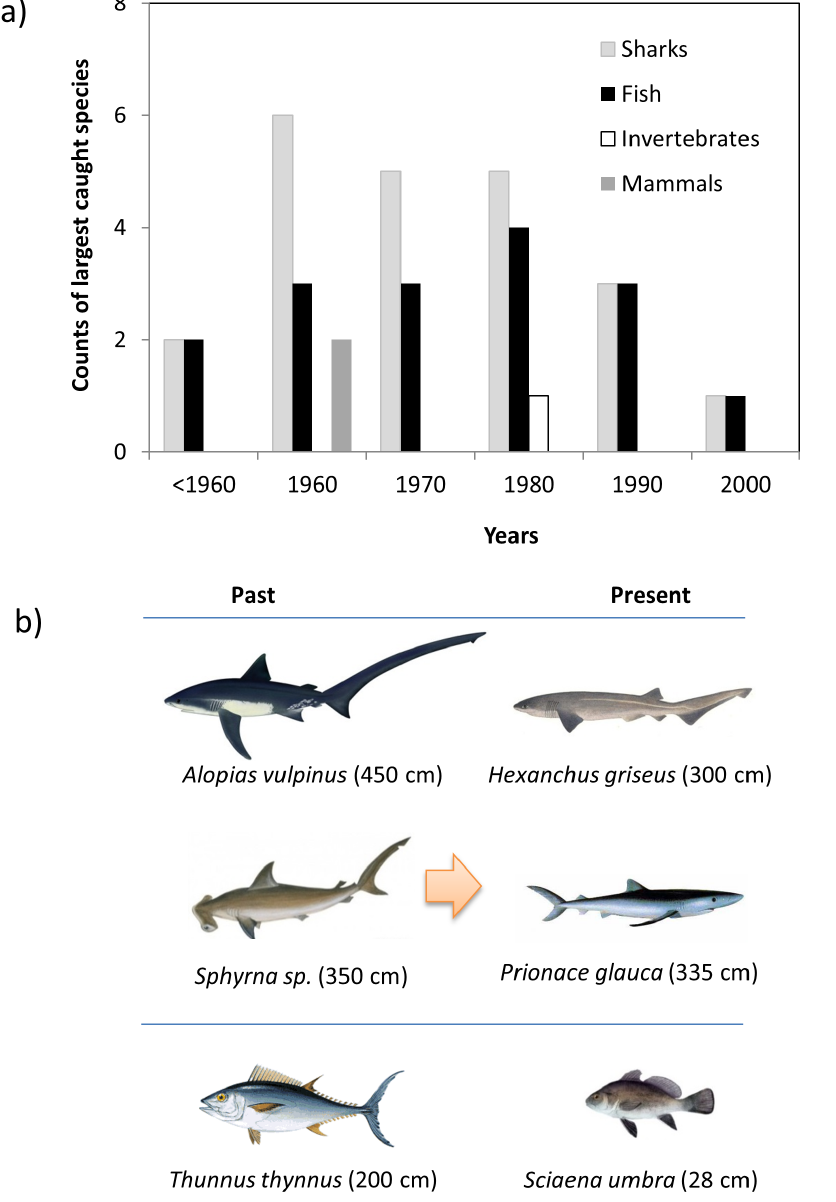
Figure 8. Composition of the largest caught species listed by fishers a) by decade and main species group, and b) main cartilaginous and bony fish species reported during the first and last decades and their mean length (species drawings: http://ian. umces.edu/symbols & www.gencat.cat).